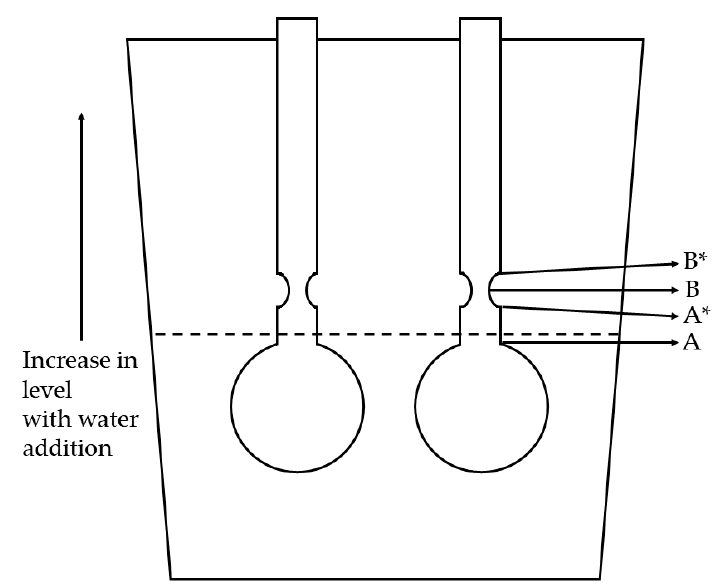
Figure 10. Depiction of solution levels and immersion of tuning forks.